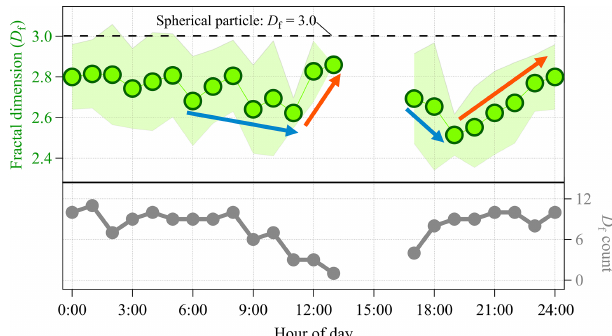
Figure 6. Diurnal cycle of fractal dimension ( D f ) of the sub-density mode particles. The dotted line is D f with a value of 3.0, indicating particles with a spherical morphology. The blue arrows represent D f with a decreasing trend, and the orange arrows represent D f with an increasing